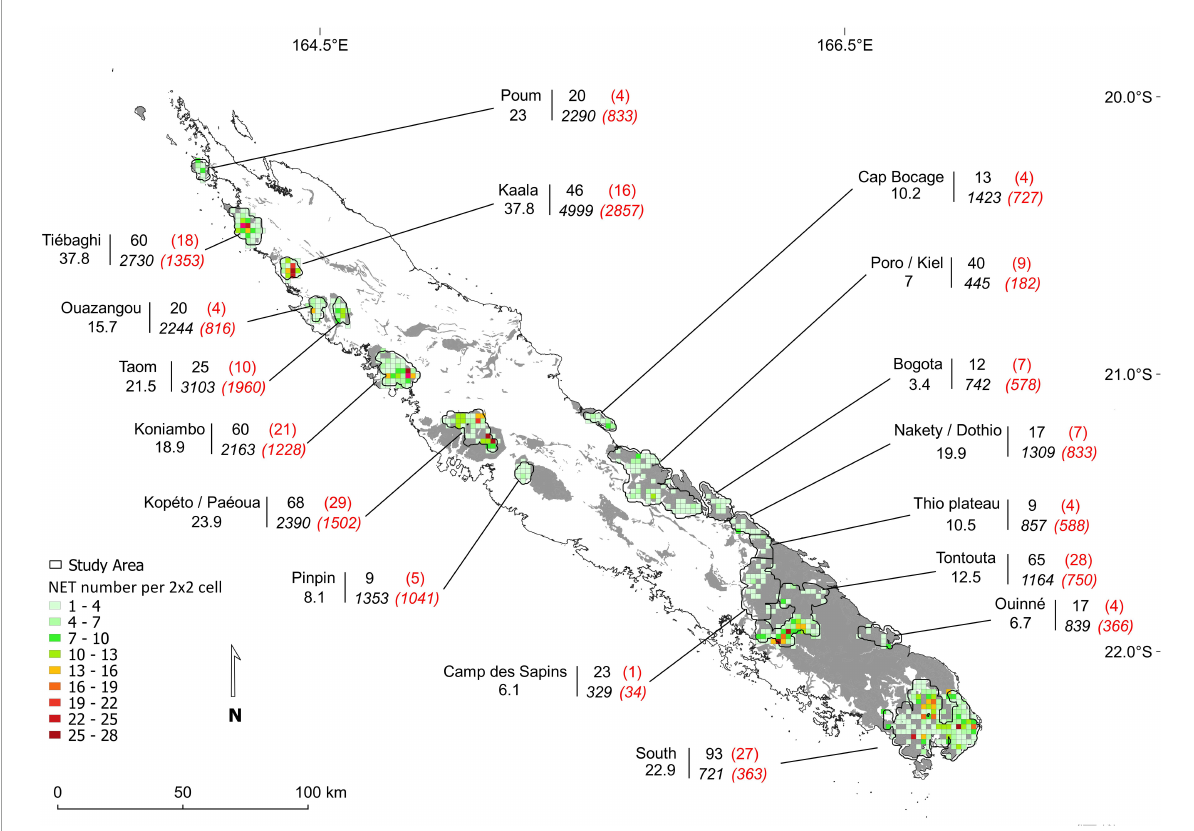
Frontiers in Ecology and